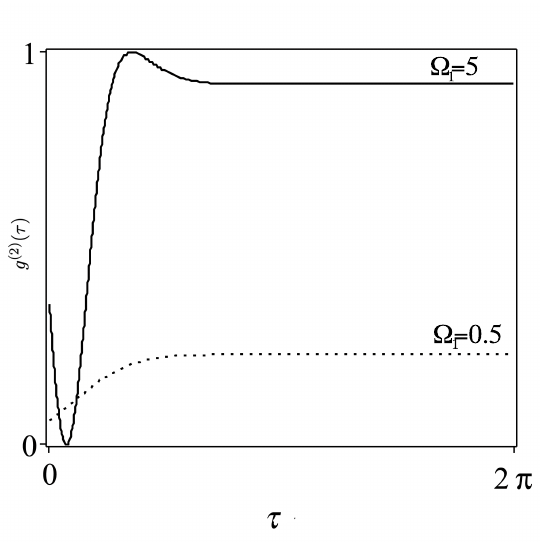
Figure 4. g ( 2 ) ( τ ) against τ for one pulse case, n = 1, with different Ω 1 = 0.5,5.